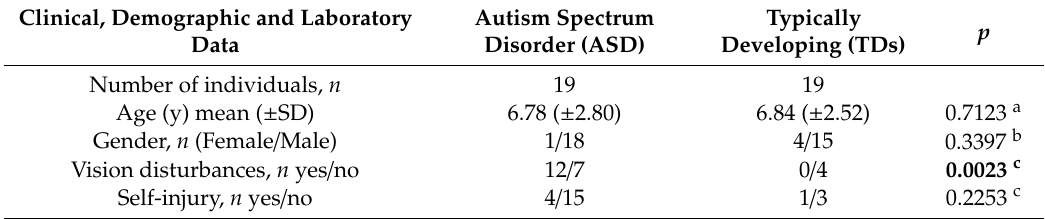
Table 2. Detailed characteristics of laboratory, demographic and clinical parameters in ASD and TD